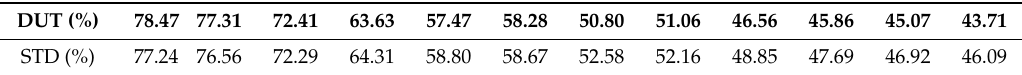
Table 1. Calibration mappings for a temperature sensor in the Bao farm.